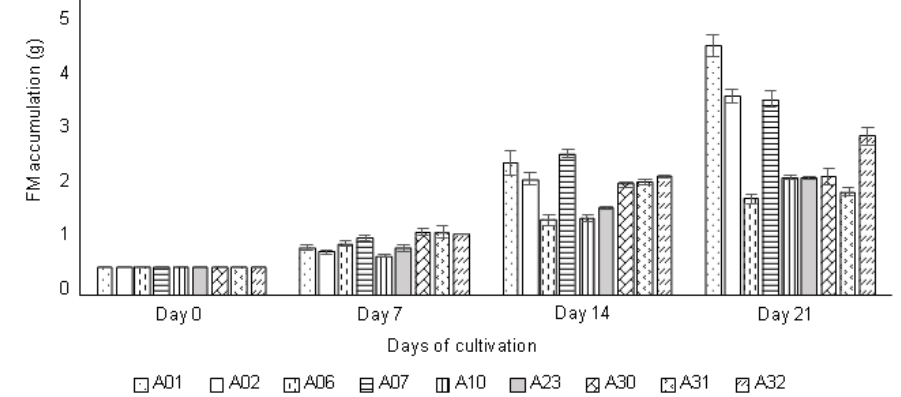
Figure 2. Fresh mass (FM) accumulation (g) in selected cell lines (A01...A32) during the growth cycle; at day 0, the fresh mass was 0.5 g for all cell lines (n = 10).